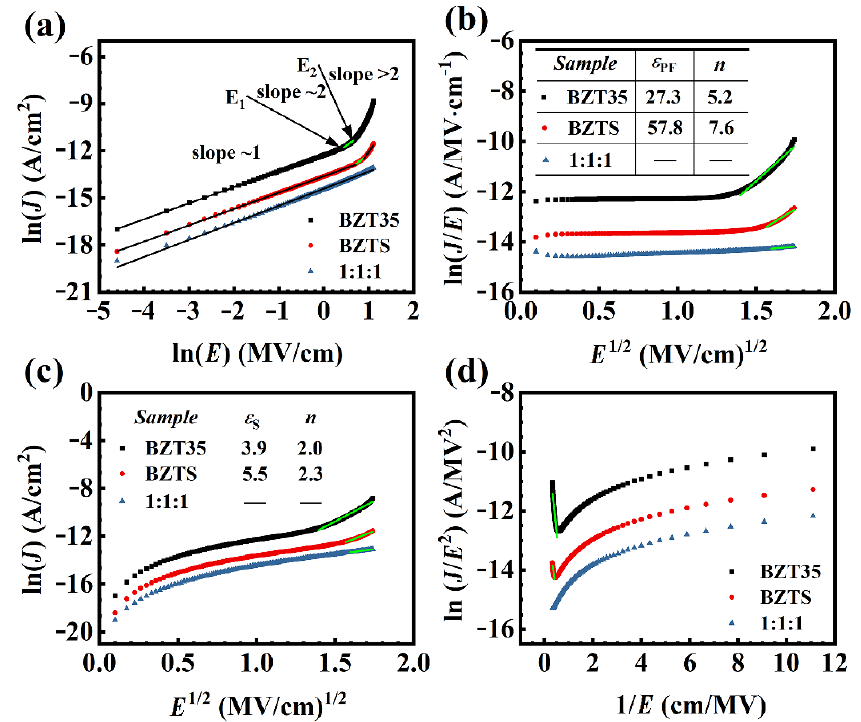
Figure 3. The ln( J ) vs. ln( E ) ( a ), ln( J / E ) vs E 1/2 ( b ), ln( J ) vs E 1/2 ( c ) and ln( J / E 2 ) vs. 1/ E ( d ) for BZT35, BZTS and BZT35/BZTS/BZT35(1:1:1) films under 200 °C. BZTS and BZT35/BZTS/BZT35(1:1:1) films under 200 ◦